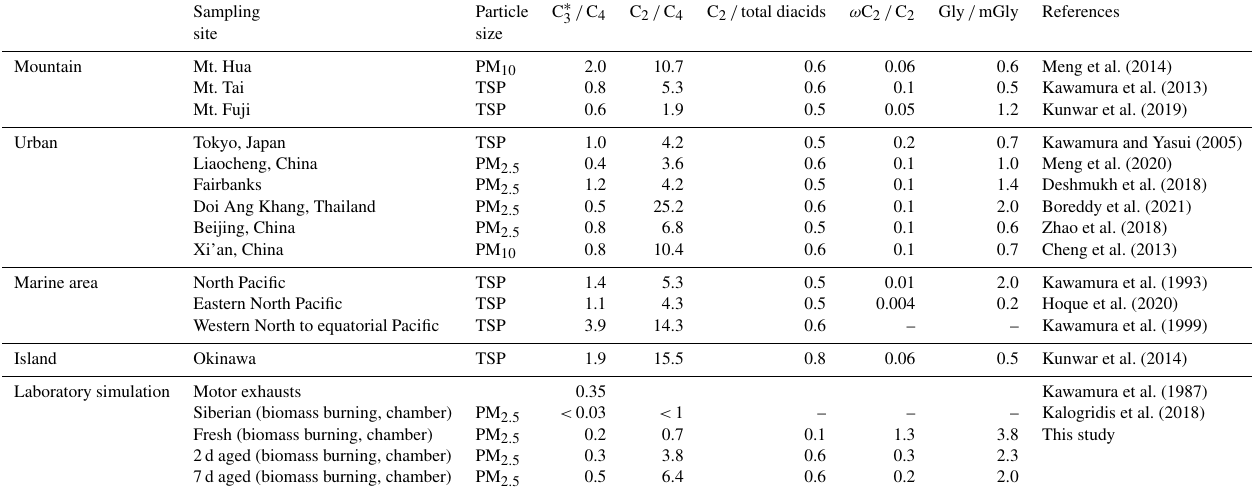
Table 2. Comparison of mass ratios of C 3 / C 4 , C 2 / C 4 , C 2 / total diacids, ω C 2 / C 2 and Gly / mGly in fresh and aged aerosols collected from biomass burning at different locations around the